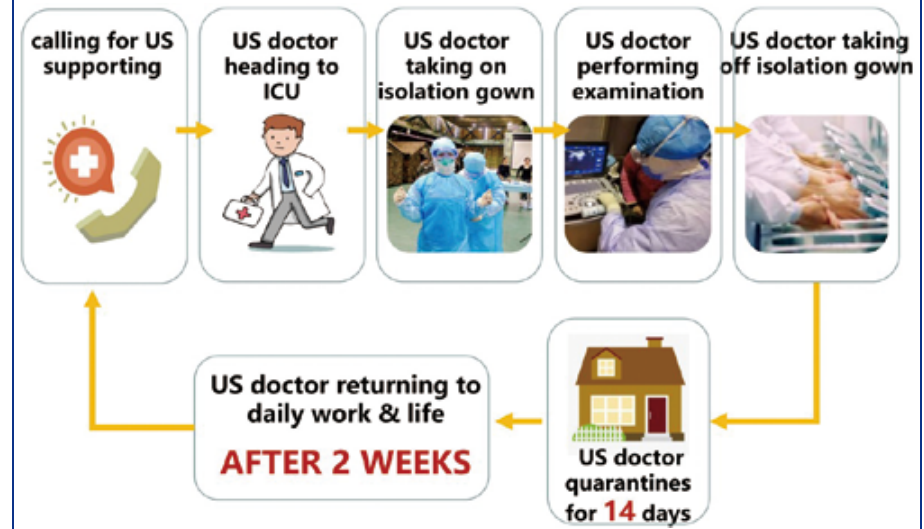
Figure 5 Workflow of bedside ultrasound (US) for COVID-19 patients: Teleultrasound (Tele-US) solution. Firstly, US imaging acquisition is performed by certain intensive physicians; then taking advantage of TUS-related technology, the well-qualified radiologists provide prompt and effective intervention from a